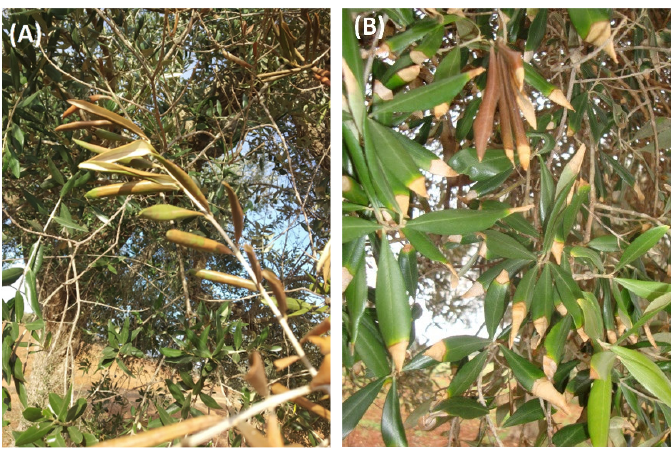
Figure 10. Early symptoms induced by Neofusicoccum mediterraneum ( A ) and Xylella fastidiosa subsp. pauca ( B ) on olive leaves.